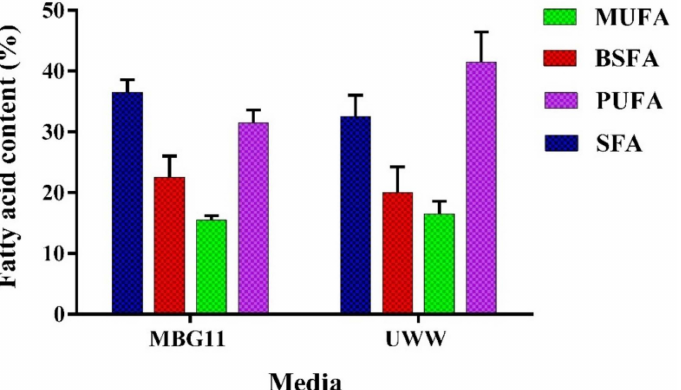
Figure 3. FAME analysis of the biodiesel derived from the lipids extracted from P. terebrans BERC10 biomass produced in MBG11 and UWW. Mono-unsaturated Fatty Acids = MUFA, Branched Saturated Fatty Acids = BSFA, Poly Unsaturated Fatty Acids = PUFA, and Saturated Fatty Acids = SFA.